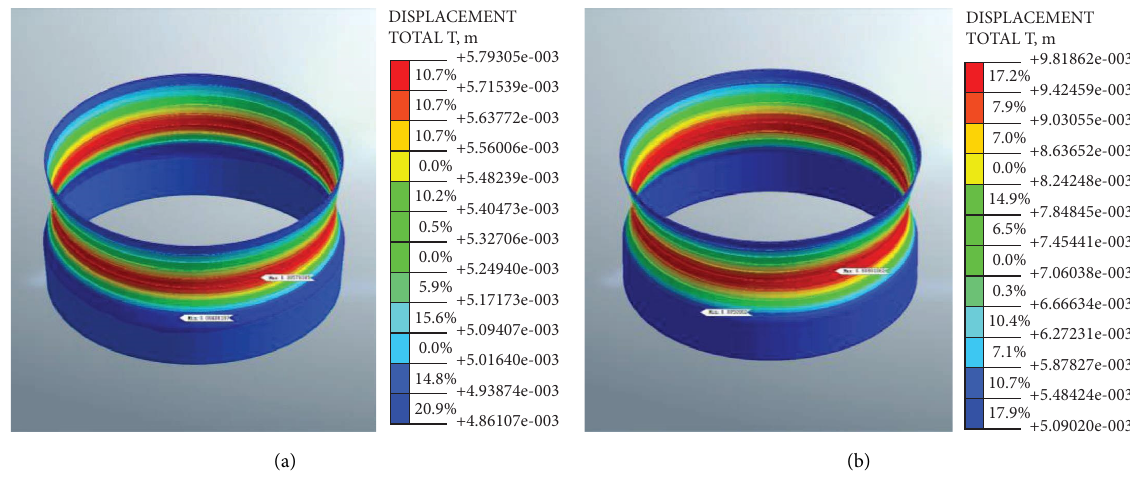
Figure 27: Working condition 9 wall deformation (a) without pore water pressure and (b) with pore water pressure